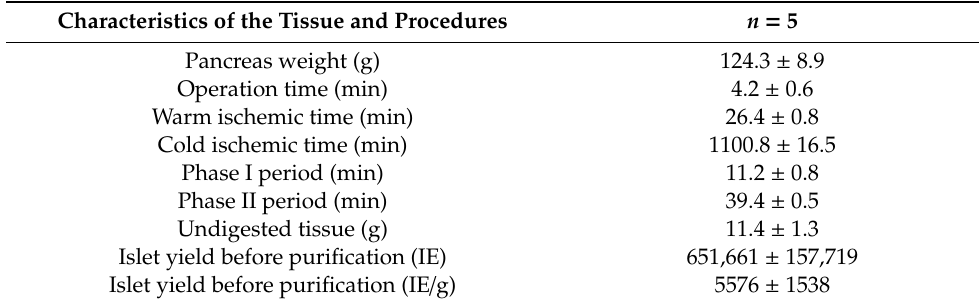
Table 1. Characteristics of the tissue and procedures before purification. Characteristics of the Tissue and